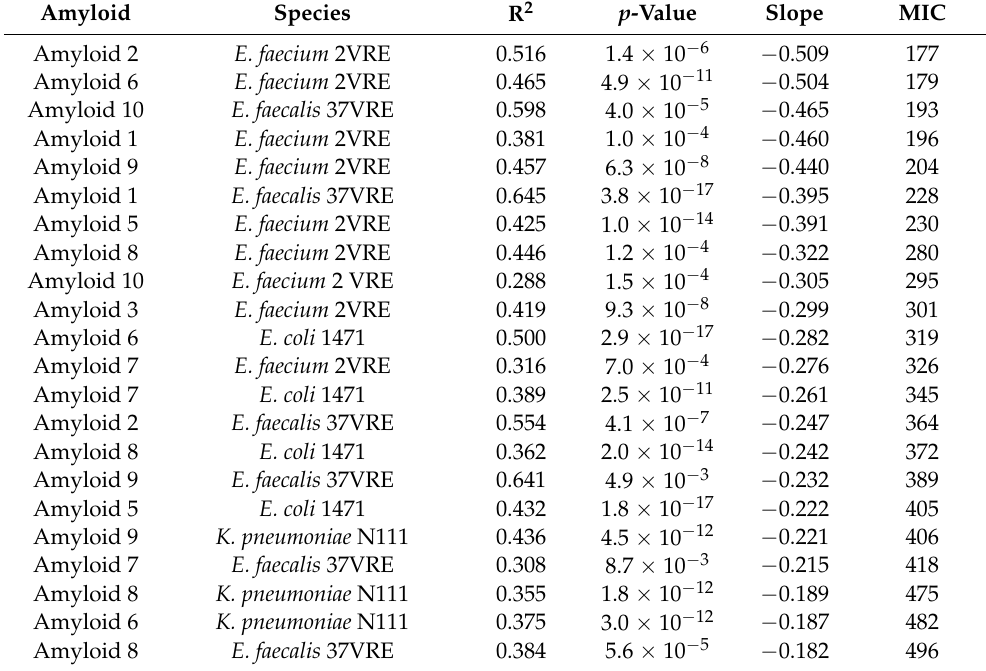
Table 3. Parameters of regression analyses for viability of the bacterial strains subjected to ten amyloids and the MIC values calculated on the basis of the obtained models lower than 512 µ g/mL. R 2 states for coefficient of